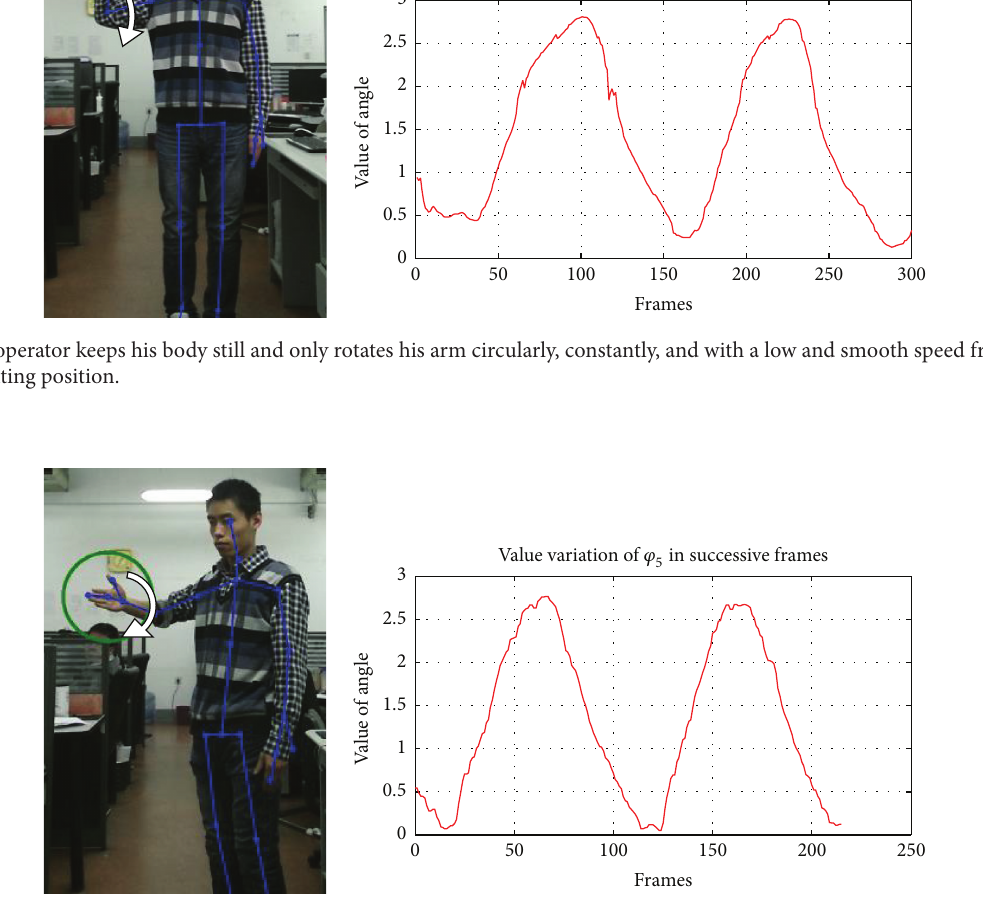
Figure 7: The operator keeps his body still and only rotates his elbow circularly, constantly, and with a low and smooth speed from the origin position to limiting position.